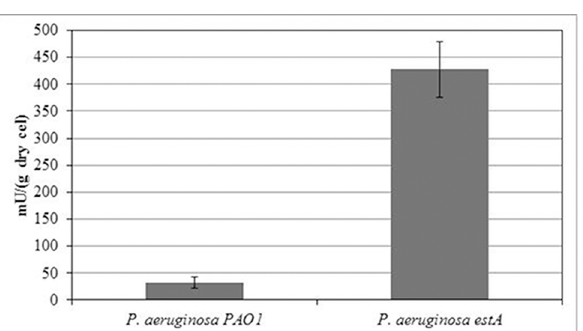
Fig 1. Esterase activity of wild type and recombinant strain. Recombinant strain was created by the insertion of pUCP26-estAplasmid, that contains estA gene, for encoding an outer membraneesterase. Esterase activities for the wild type P . aeruginosa PAO1 and the recombinant P . aeruginosa -estA were carried out using MUH (C7) as a substrate, at 30˚C and pH = 7. A Student’s t-test was performed and it is affirmed that the data are significantly different from each other (p < 0.5).